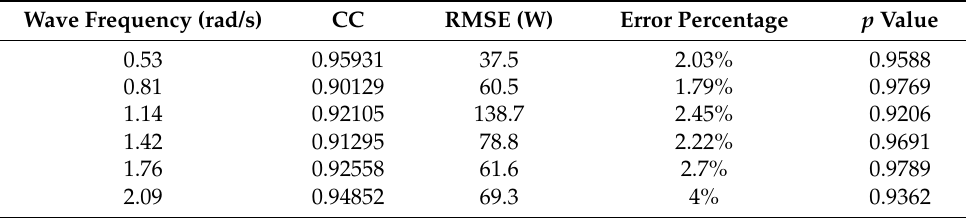
Table 3. The statistical parameters between desired and forecasting results. Wave Frequency (rad/s) CC RMSE